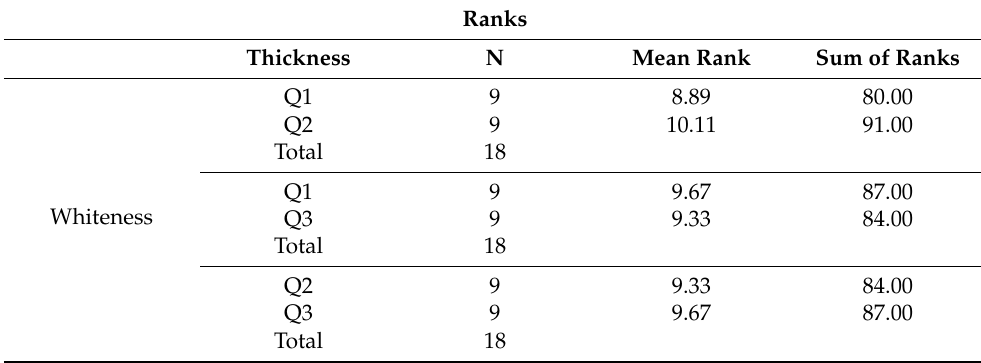
Table A4. Ranks table of Mann–Whitney U test for the whiteness according to the thickness.